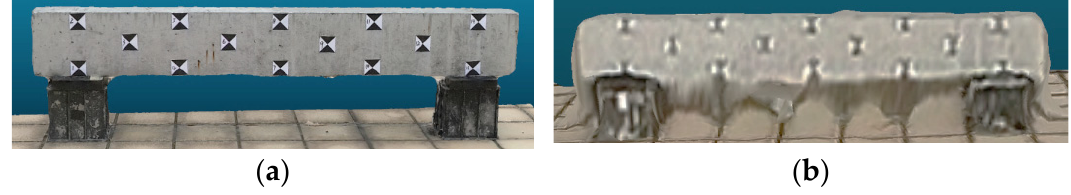
Figure 7. 3D model of concrete beam: ( a ) the model of FR; ( b ) the model of SR. Table 3. The effect of different routes on reconstructed quality of the 3D beam model.